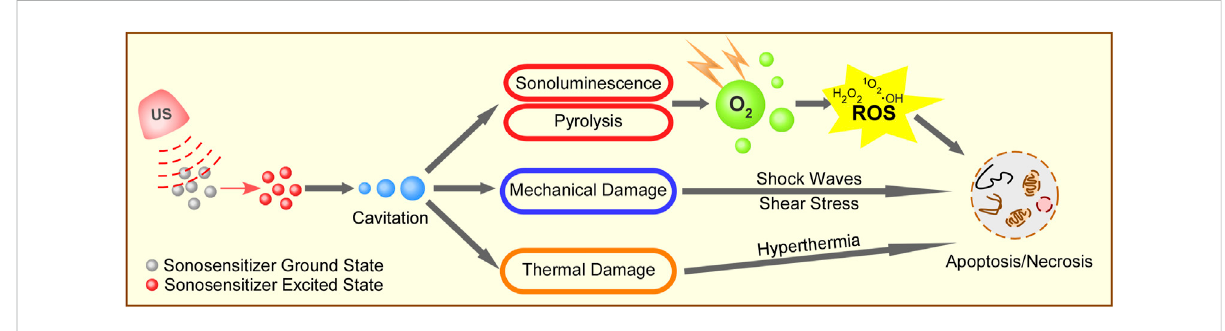
FIGURE 1 Schematicillustrationof possible mechanisms ofSDT. Ultrasound irradiation activates sonosensitizer from aground state to an excited state to formcavitationaroundthesurfaceofcancercells.Theenergyfromthecollapseofcavitatingbubblescaninitiatesonoluminescentlight,mechanical damage, and thermal damage to cancer cells. The energy can be transferred to the circumambient oxygen to produce a large amount of ROS, including singlet oxygen, peroxide, and hydroxyl radical, which subsequently mediate cell apoptosis and necrosis. At the same time, the cavitation also causes shock waves, shear stress, and hyperthermia to induce cell